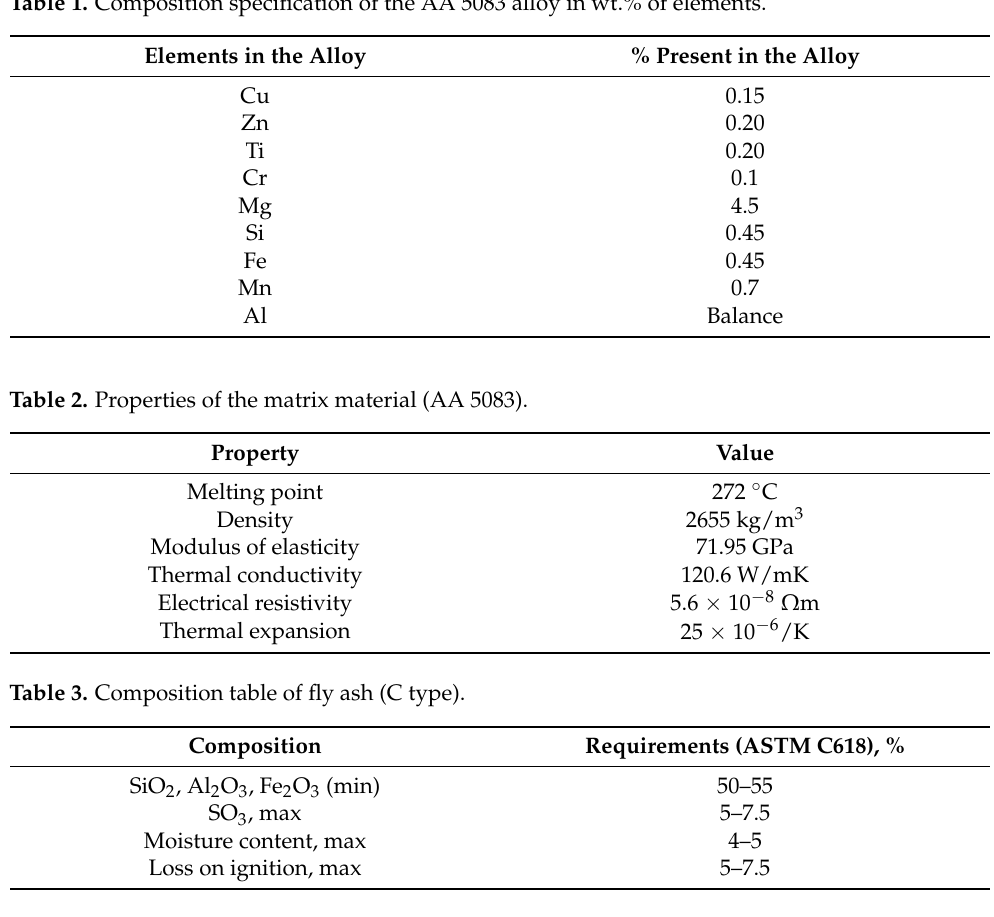
Table 4. Property table of silicon carbide